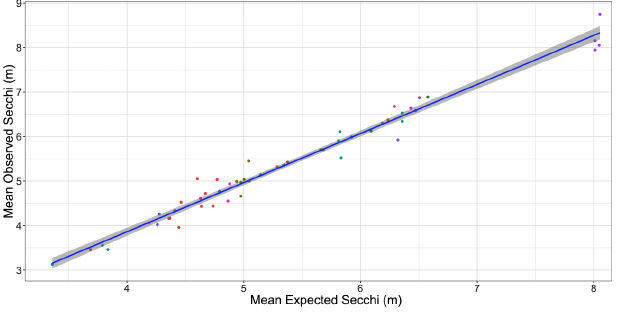
Fig. 2 . Final model, with all 53 sites plotted according to their mean observed Secchi values between 2001 and 2013 and mean expected Secchi from fitted linear mixed effects